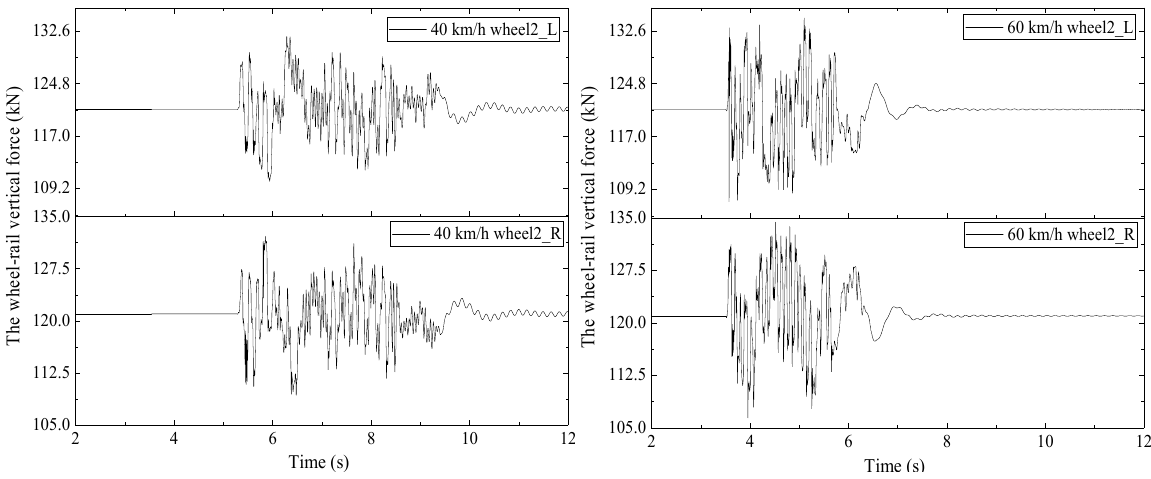
Figure 20. The wheel-rail force time-history curves.